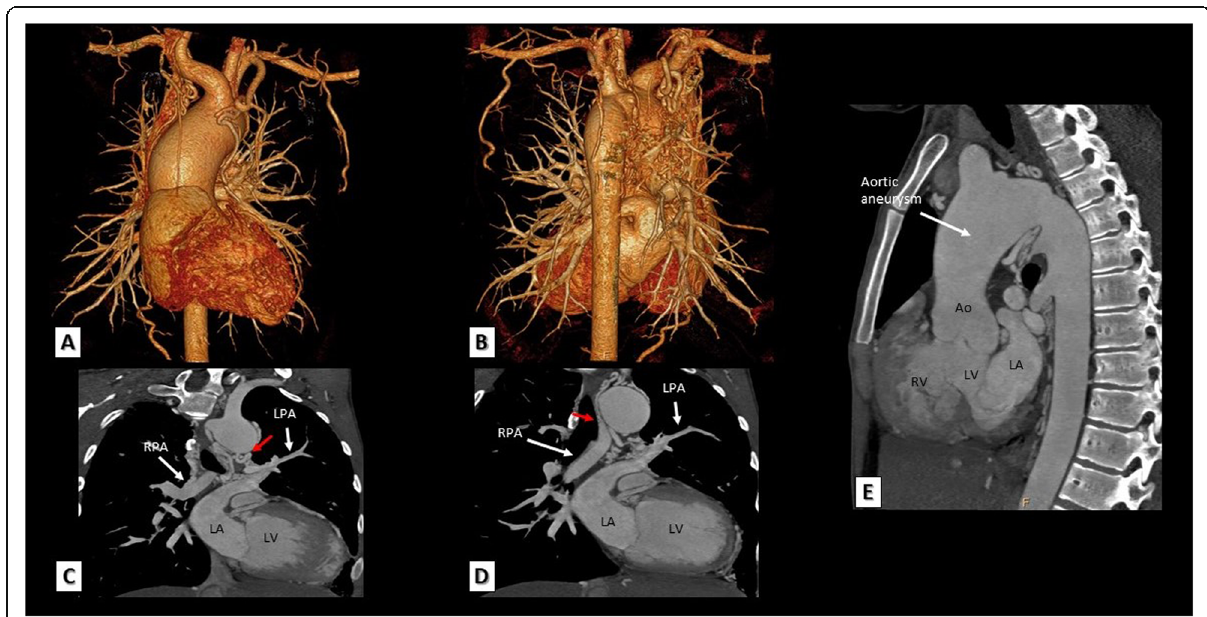
Fig. 2 A neglected adult case with TOF and pulmonary atresia. a , b 3D VRT MDCT images showing innumerous MAPCAs filling the mediastinum arising from descending thoracic aorta as well as right and left subclavian and internal mammary arteries. c , d Reconstructed MDCT coronal images showing pulmonary atresia and non-confluent right and left pulmonary arteries arising from MAPCAs rather than main pulmonary artery (red arrows). e A reconstructed MDCT sagittal image showing ascending aortic aneurysm as a result of long-standing volume loading in this patient. Ao, aorta; RPA, right pulmonary artery; LPA, left pulmonary artery; LV, left ventricle; RV, right ventricle; LA, left